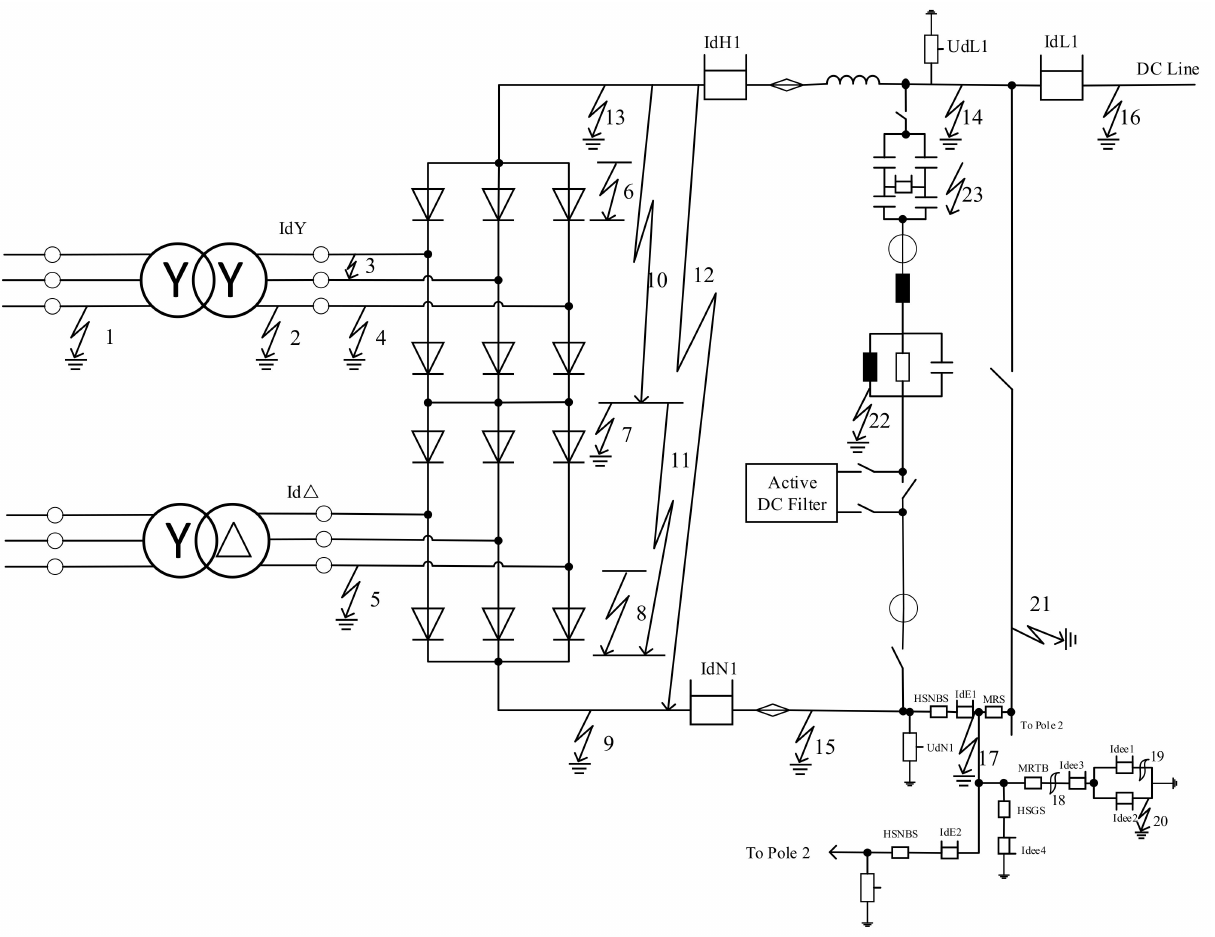
Figure 1. Major fault points of a typical HVDC